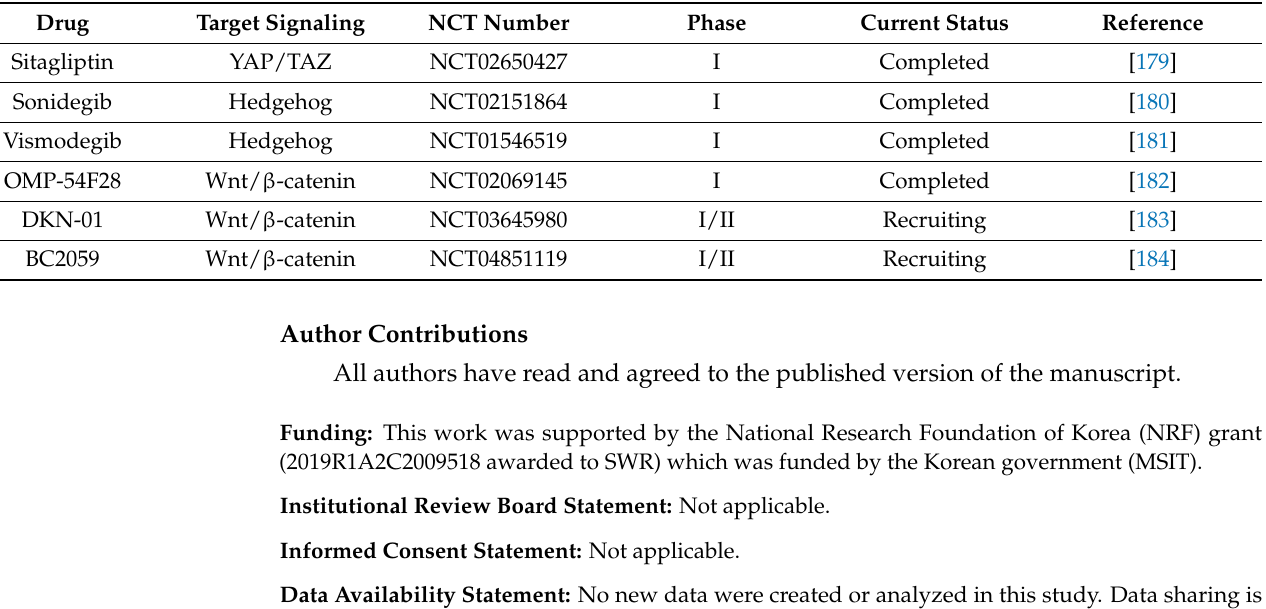
Table 4. Currently undergoing clinical trials targeting YAP/TAZ, Hedgehog Wnt/ β -catenin signaling in